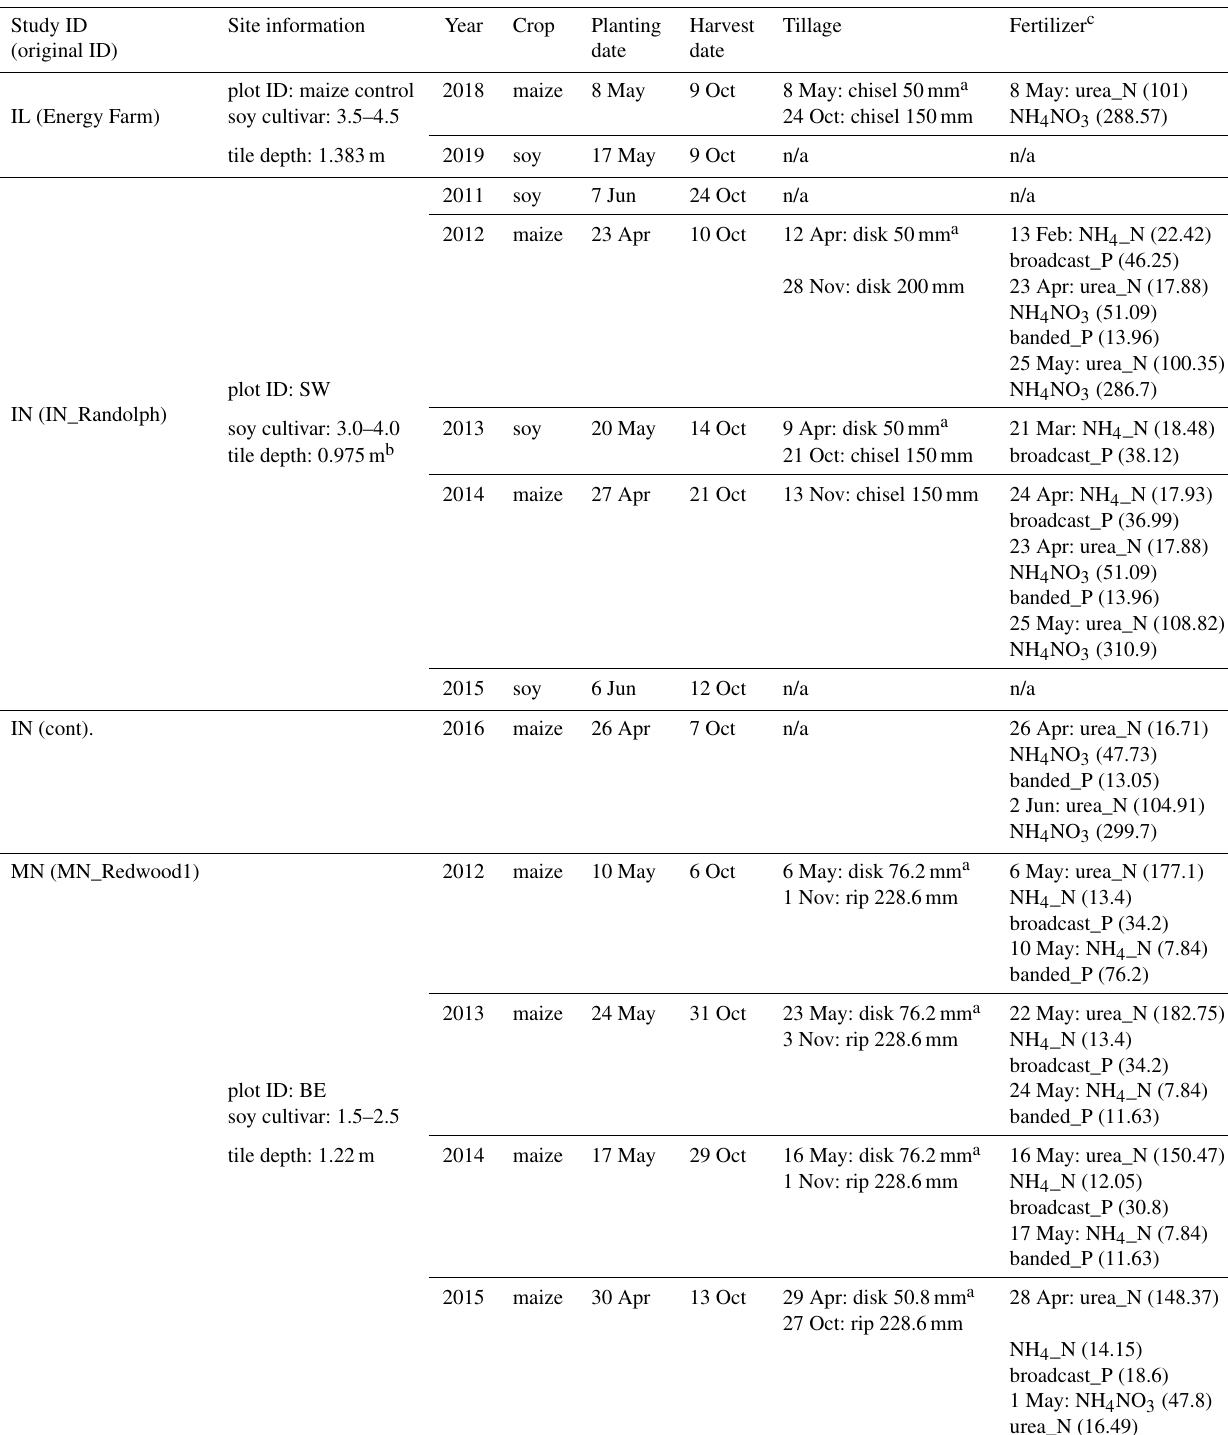
Table A1. Site management information as defined across all APSIM simulations in this